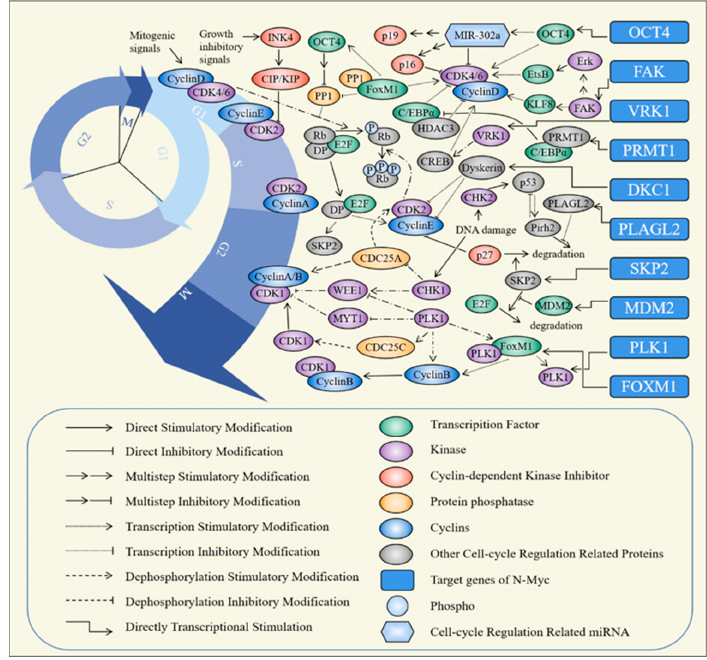
Figure 2. The mechanism of N-Myc target genes regulating cell cycle progression. The ten target genes listed on the right side can be divided into three parts. First, the expression products of genes such as POU5F1 , PTK2 , PRMT1 , MDM2 , FOXM1 , and DKC1 can act as or bind to transcription fac- tors to regulate the expression of cell cycle-related genes (primarily including CDKs and